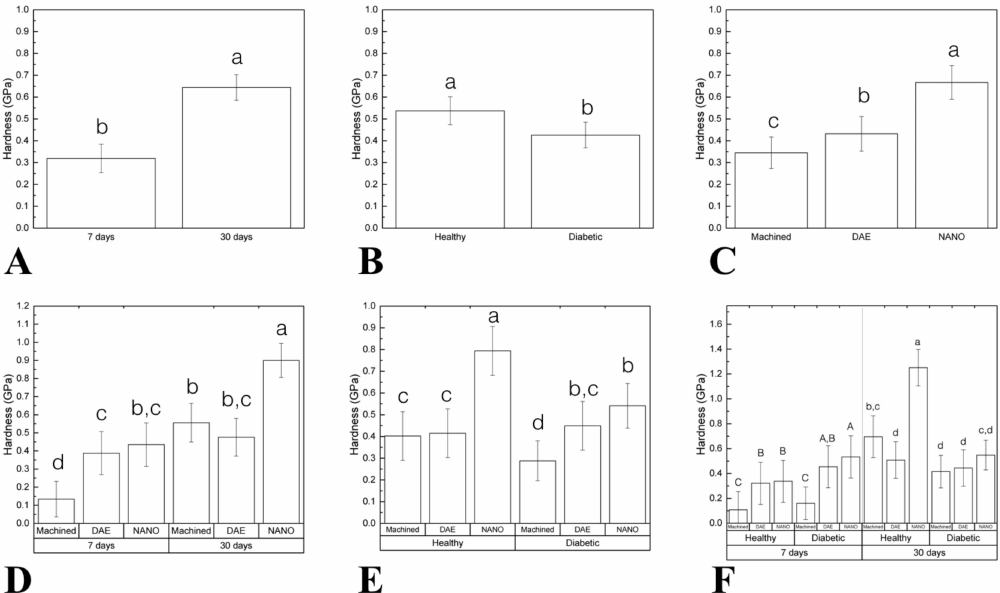
Figure 7. ( A – F ) Graphs representing hardness ( H ) di ff erently arranged as a function of study factors (mean and 95% CI). Significant di ff erence was seen between 7 and 30 days in vivo ( A ). Healthy group presented higher H when compared to diabetic (data as function of systemic condition) ( B ). When implant surface was considered, NANO group exhibited higher H relative to machined and DAE groups (data as a function of implant surface) ( C ). Data evaluation as a function of time and implant surface highlighted the superiority of NANO group at 30 days compared to others ( D